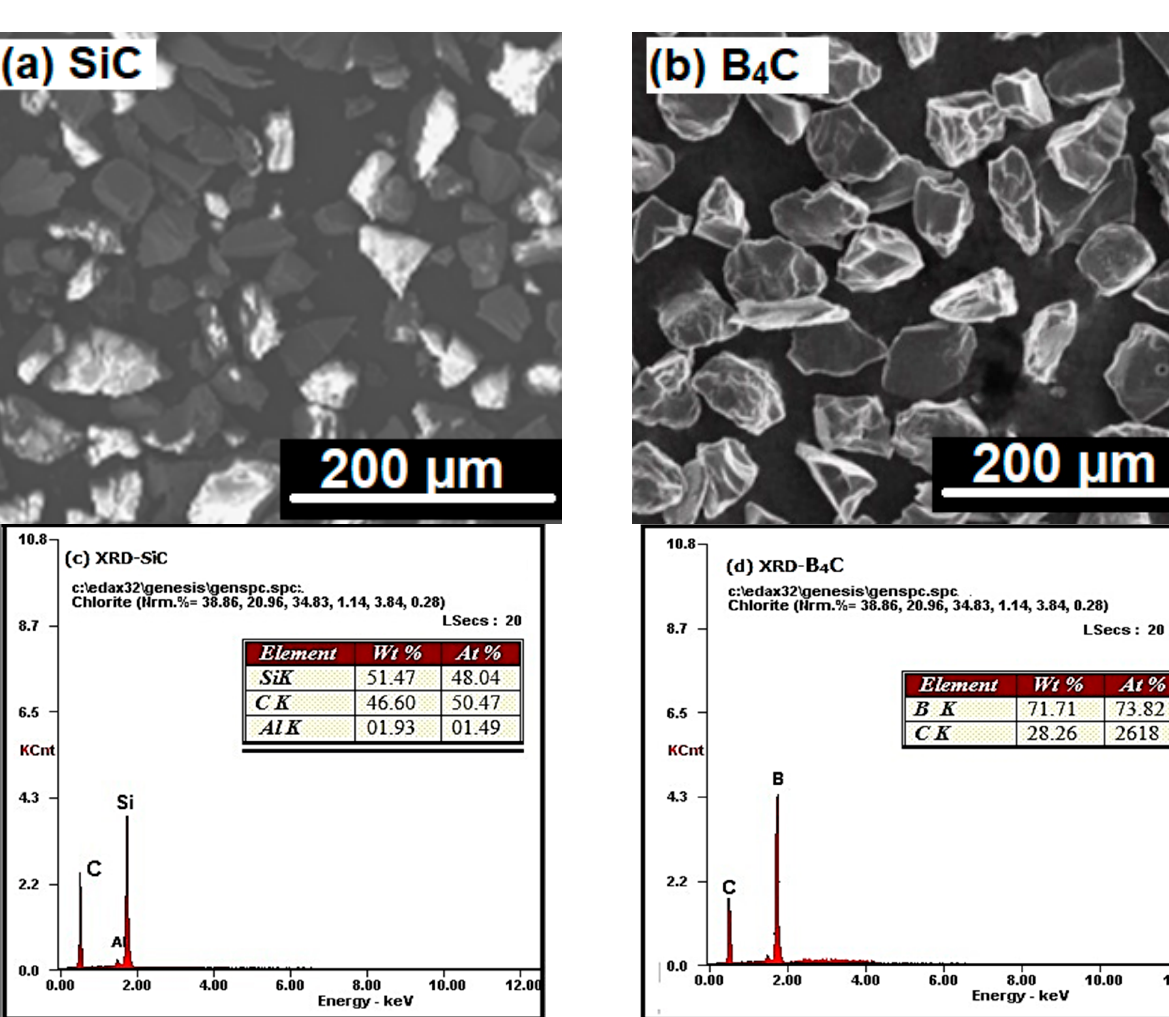
Figure 1. SEM micrographs ( a , b ) and corresponding XRD plots ( c , d ) of SiC and B 4 C particles used in the present study.